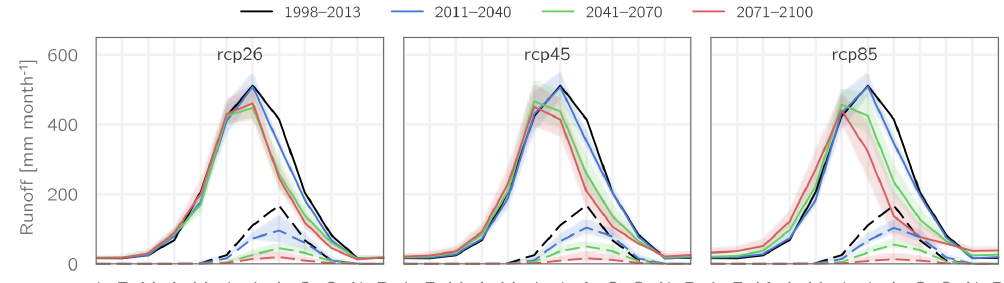
Figure 6. Shifts of streamflow regimes for the Rofenache catchment (Austrian Alps, 1891–3762ma . s . l . , 98km 2 , ∼ 35% glacierization as of 2006) as simulated with the AMUNDSEN model using downscaled EURO-CORDEX projections for the RCP2.6, RCP4.5 and RCP8.5 scenarios. Solid and dashed lines indicate the multimodel mean total and ice melt runoff, respectively, and shaded bands indicate the climate model uncertainty shown as ± 1SD. Adapted from Hanzer et al.